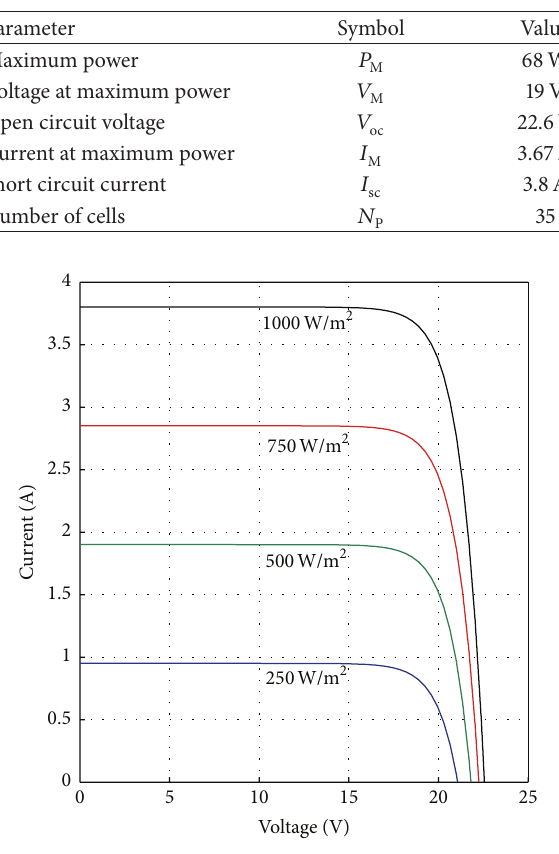
Figure 4: MATLAB model 𝐼 - 𝑉 curves for various irradiation levels.